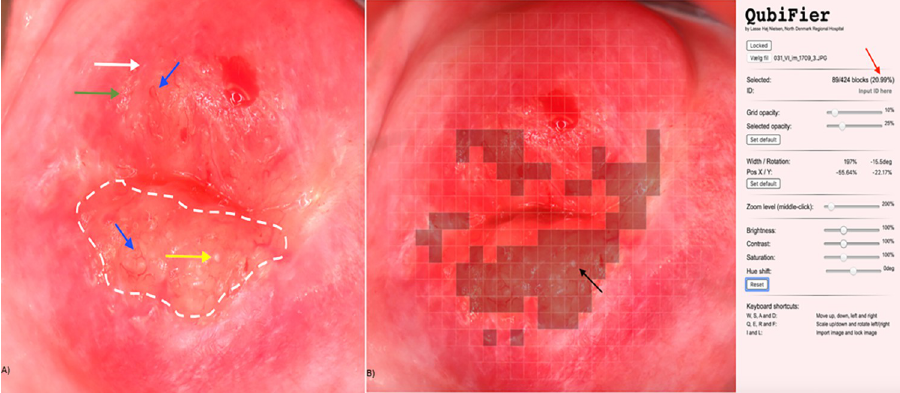
Fig 1. Digital image showing female genital schistosomiasis associated pathognomonic lesions of the cervix (picture A) and the same lesions being digitally marked by QubiFier to determine the cervical lesion proportion (picture B). The left picture (A) shows an area, which contains homogenous yellow sandy patches appearing as yellow colored area (indicated by white dashed line). The differently colored arrows indicate the other pathognomonic lesion types: a grainy sandy patch (white arrow), clustered grainy sandy patches or rice-grain shaped sandy patches (green arrow) and a rubbery papule colored in beige with an uneven surface (yellow arrow). Abnormal blood vessel (rounded, uneven-calibered, corkscrew or convoluted) are indicated by the blue arrow. The right picture (B) shows squares of the grid marked digitally containing any types of pathognomonic lesions. The red arrow shows the proportion of the cervix covered by any type of pathognomonic